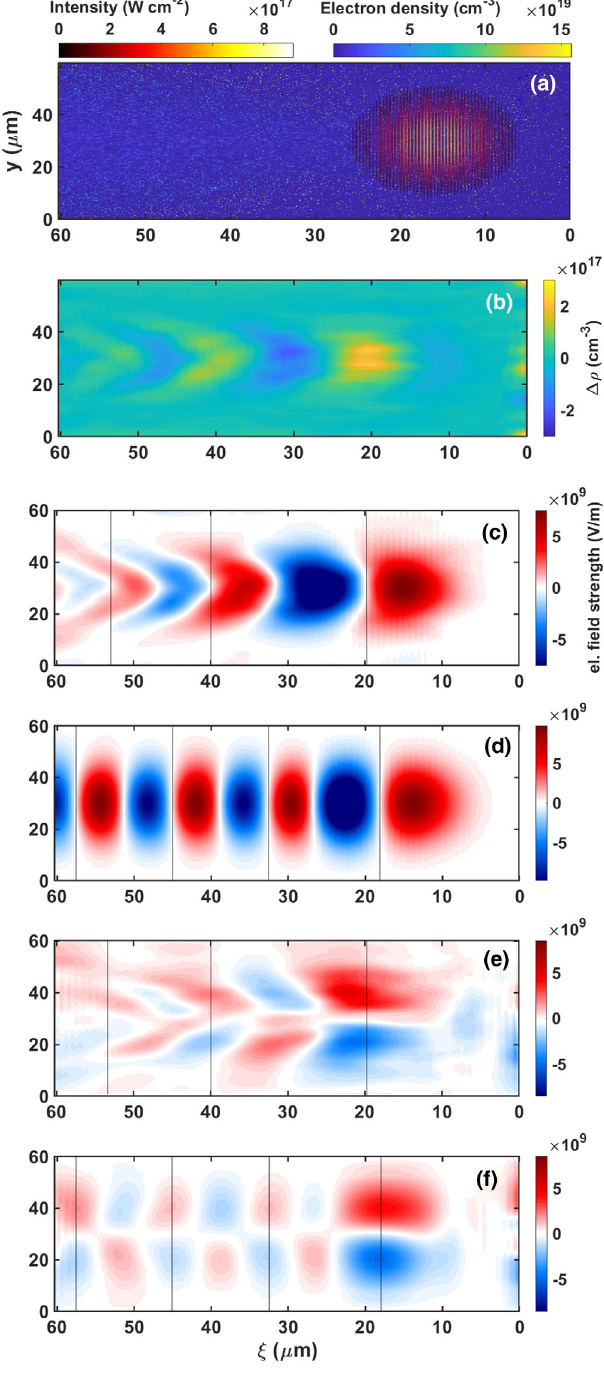
FIG. 4. Results of the 2D moving-window particle-in-cell simulations where the laser pulse propagates toward the right- hand side of the window. Panel (a) shows the electron density and the laser intensity in a cluster plasma. Panel (b) shows perturbationsinthechargedensity.Panel (c)showsthelongitudinal electric field in propagation direction of the wakefield in a cluster plasma. Panel (d) shows an equivalent simulation for a uniform plasma. Panel (e) shows the transverse electric field in a cluster plasma. Panel (f) shows an equivalent simulation for a uniform plasma. The laser duration for both simulations was 45 fs. The average electron density was 6 . 97 × 10 18 cm − 3